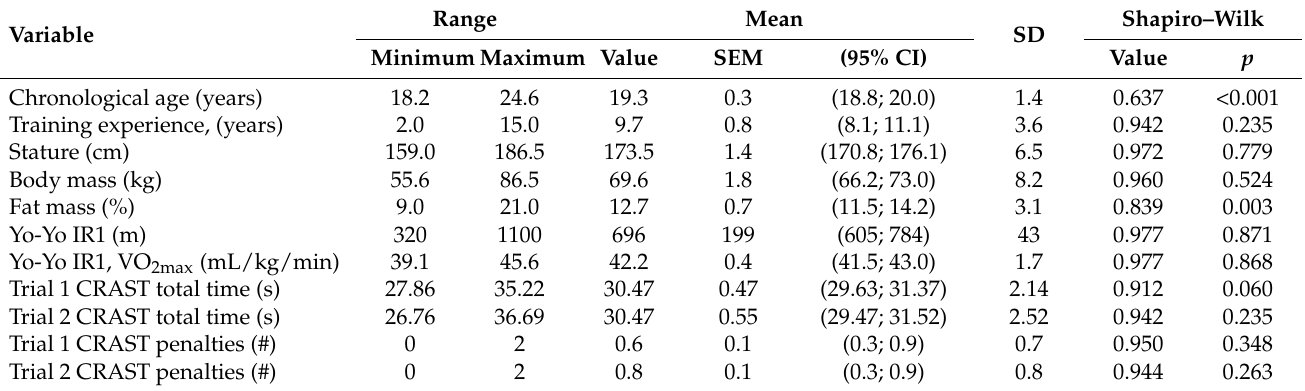
Table 1. Descriptive statistics for the total sample (n = 21).